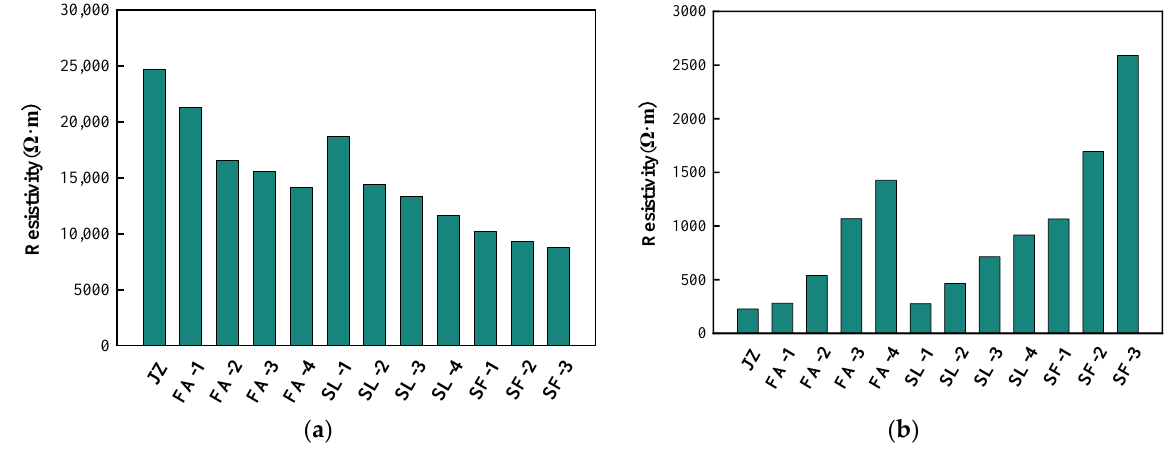
Figure 4. The resistivity of cement mortar: ( a ) Resistance in dry conditions; ( b ) Resistance after 36 d of capillary water absorption.